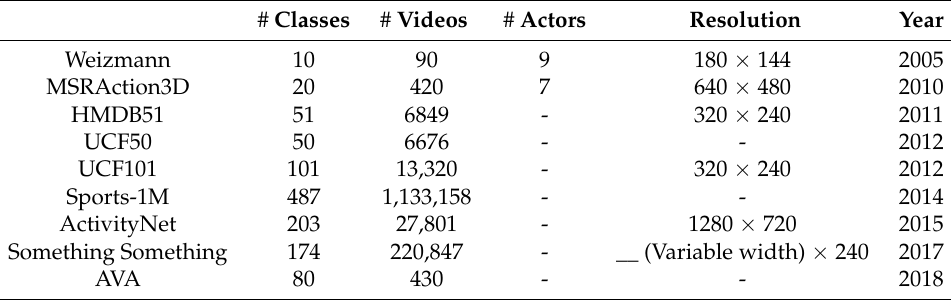
Table 5. Summary of the presented